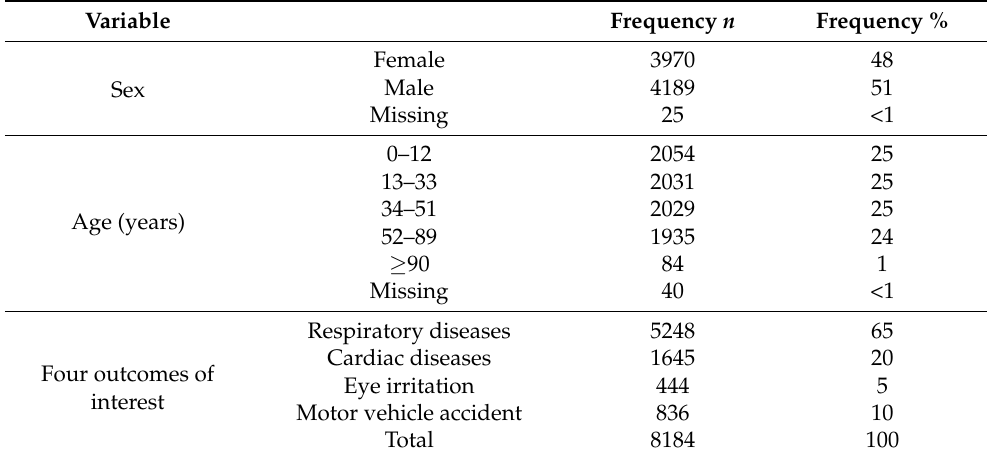
Table 1. Descriptive findings for the hospital admissions by gender, age, and outcomes of interest for admission for 1 January 2011 to 31 December 2017 (data available n = 8173, missing data for 11 individuals).